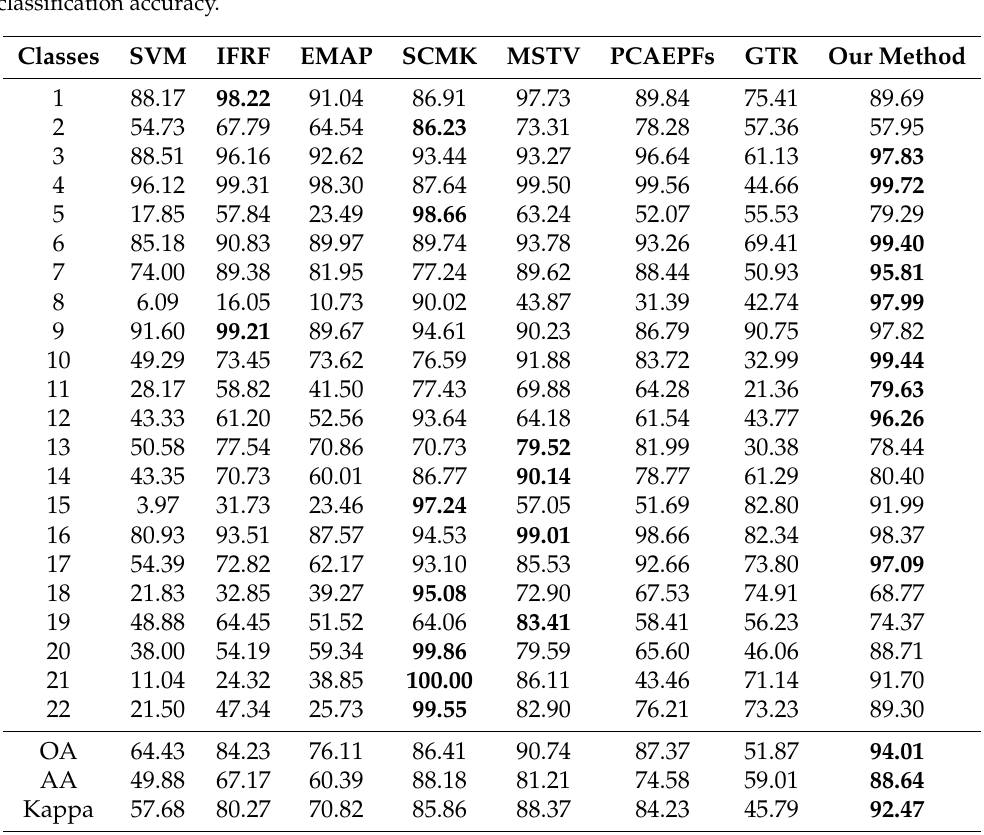
Figure 10. Classification performance of different approaches on the Honghu with different numbers of training samples. ( a ) OA. ( b ) AA. ( c ) Kappa. Table 4. Classification performance of all methods on Honghu dataset. The bold denotes the best classification